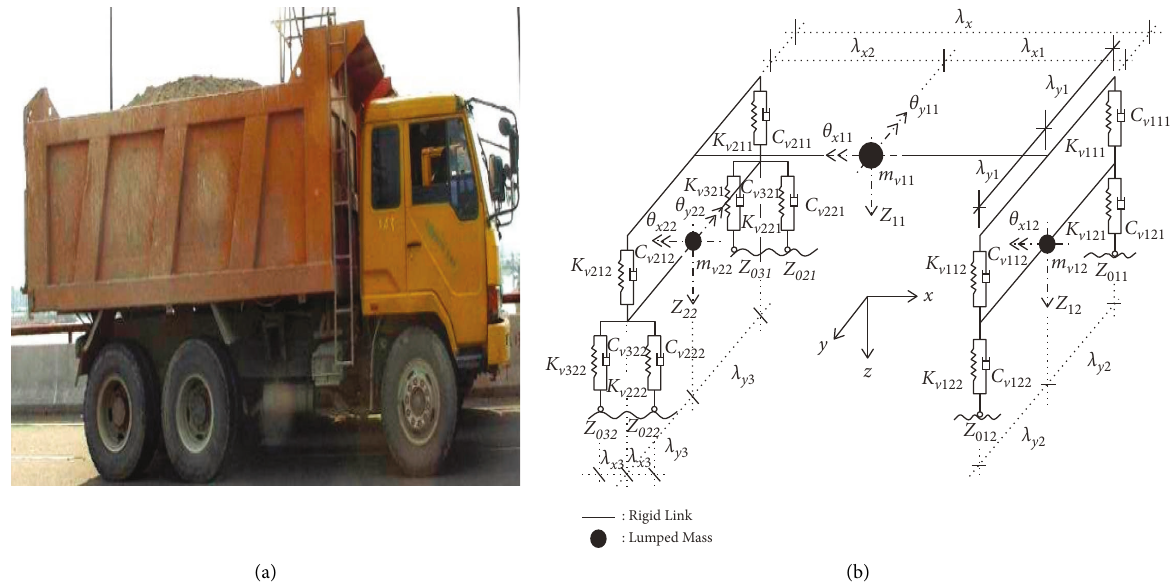
Figure 6: Heavy vehicle model. (a) Test heavy vehicle. (b) Three-axle vehicle with eight degrees of freedom.